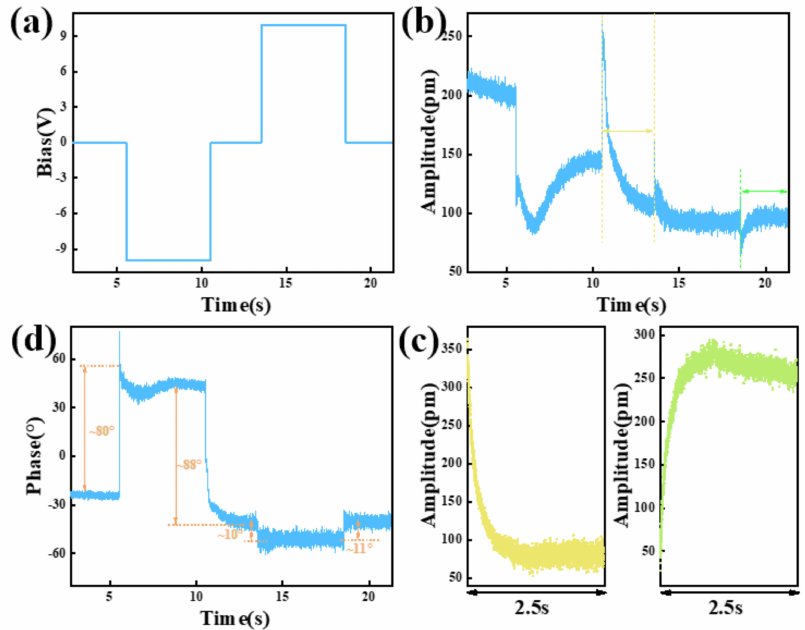
Figure 4. Relaxation dynamics in local electrochemical strain measurements of CIPS. ( a ) Illustrated DC profile applying in the relaxation measurements. ( b , d ) ESM amplitude-time and phase-time curves were obtained corresponding to the DC profile. ( c ) Zoomed—in relaxation curves of ( b ) were recorded after removing negative and positive DC voltage,